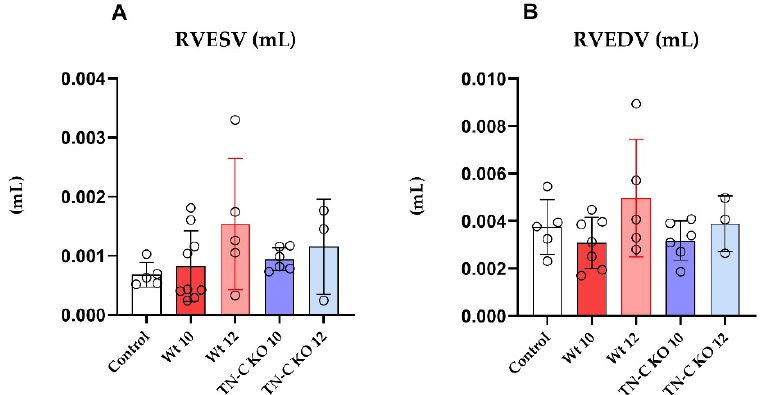
Figure 3. ( A ) Right ventricular end-systolic volume (RVESV) and ( B ) Right ventricular end-diastolic volume (RVEDV) in control, Wt 10, Wt 12, TN-C KO 10, and TN-C KO 12 mice. Wild-Type 10 weeks (Wt 10), Wild-Type 12 weeks (Wt 12), Tenascin-C knockout 10 weeks (TN-C KO 10), and Tenascin-C knockout 12 weeks (TN-C KO 12) mice.